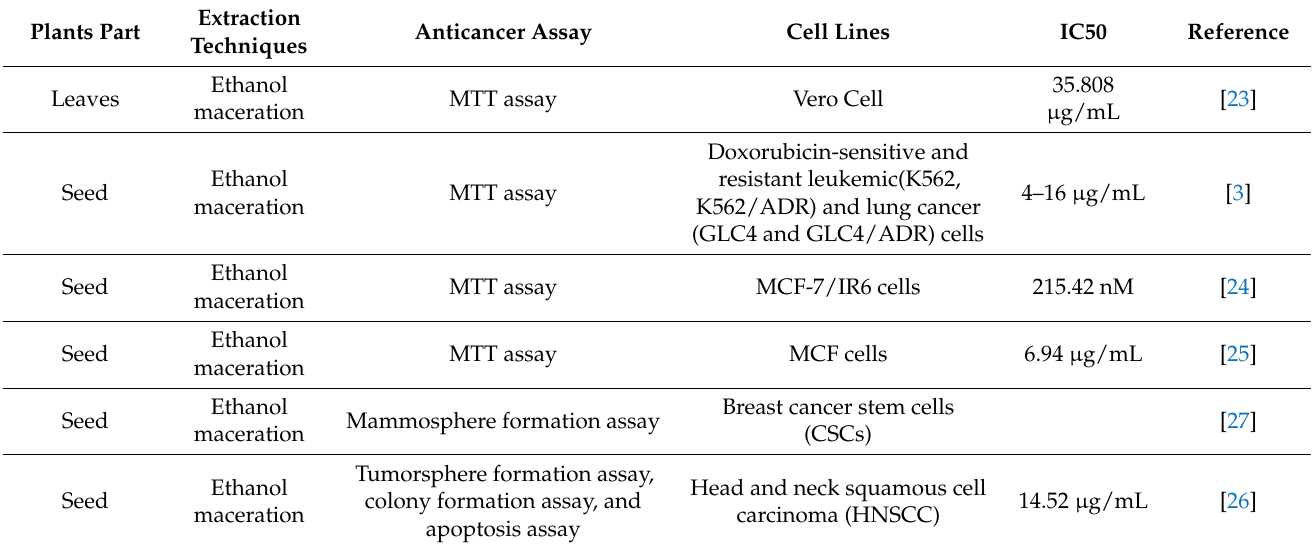
Table 2. Anticancer activity of B. macrophylla